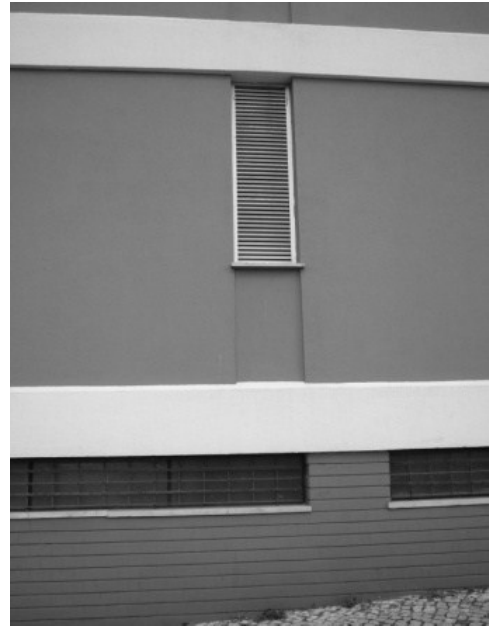
Figure 21. Detail of the window and basement.